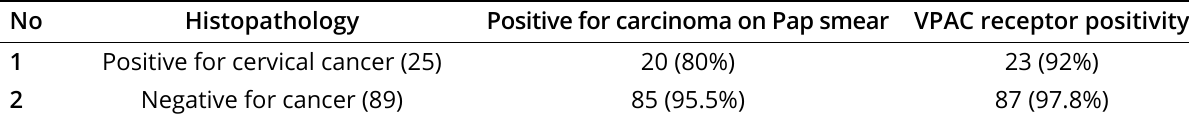
Table 3. Details of the PAP smear, HPR and VPAC receptor positivity.